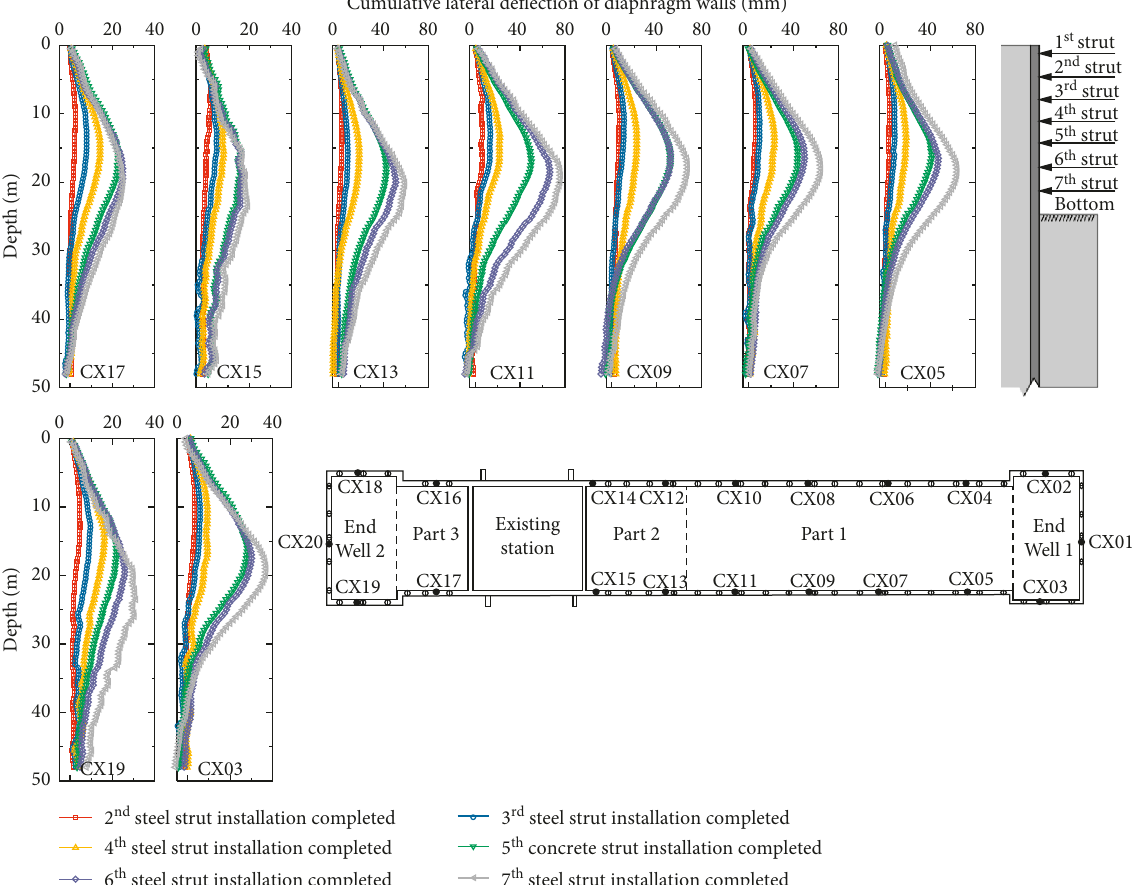
Figure 8: Curve of the measured cumulative lateral deflection of the diaphragm walls with respect to